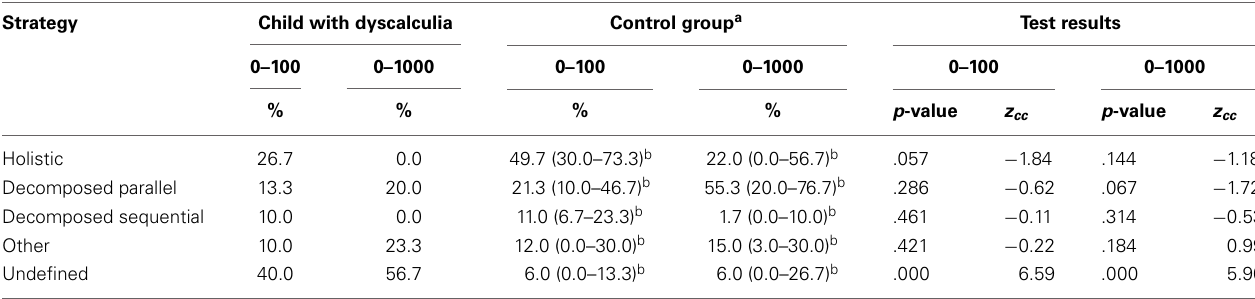
a n = 10, numbers represent the mean percentage of the 10 control children. b Range of the percentages of the 10 control children, see appendix for individual results of the control children. Z cc , obvious direct analog of Cohen’s d, subscript representing